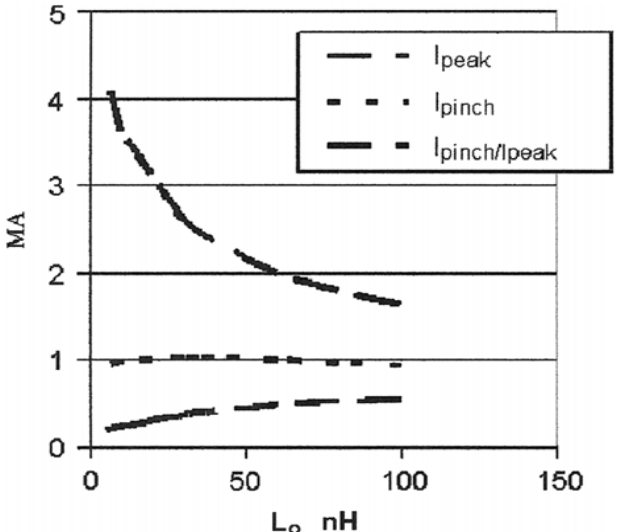
Figure 7. Effect on currents and current ratio (computed) as L 3.5 torr D 2